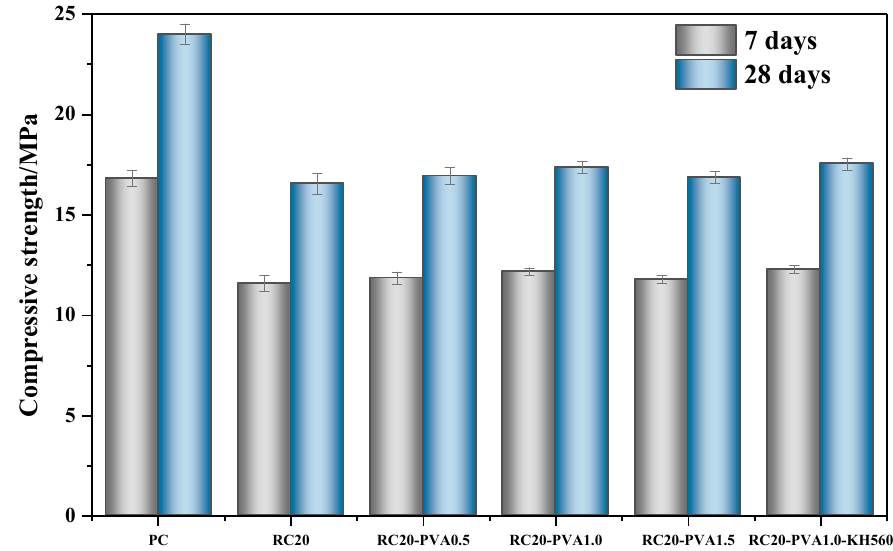
Figure 4. Compressive strength of PVA fiber rubber concrete at different dosages.